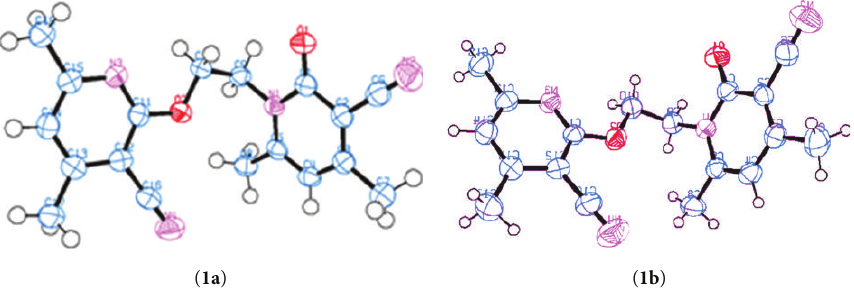
Figure 1: ORTEP diagram of polymorphs.